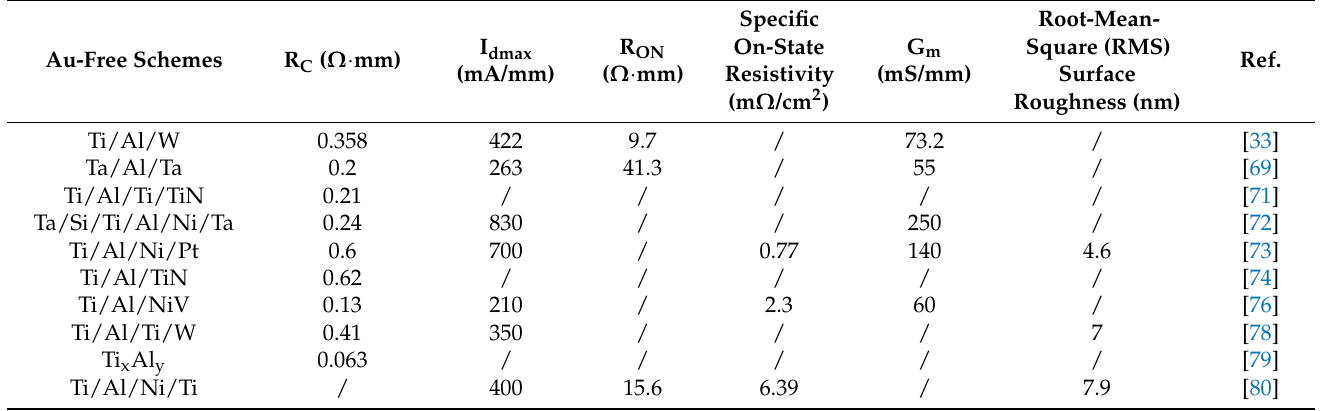
Table 2. Survey of literature data on GaN HEMTs using different Au-free ohmic contact schemes.